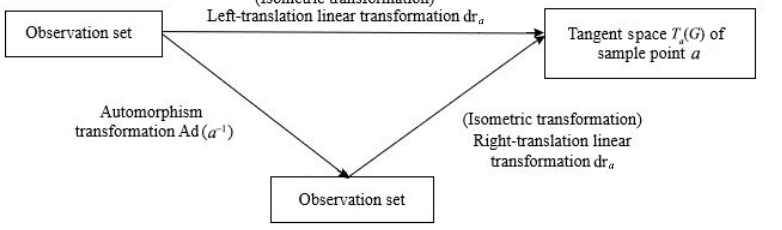
Fig. 4 Algebraic model of Lie group machine learning.